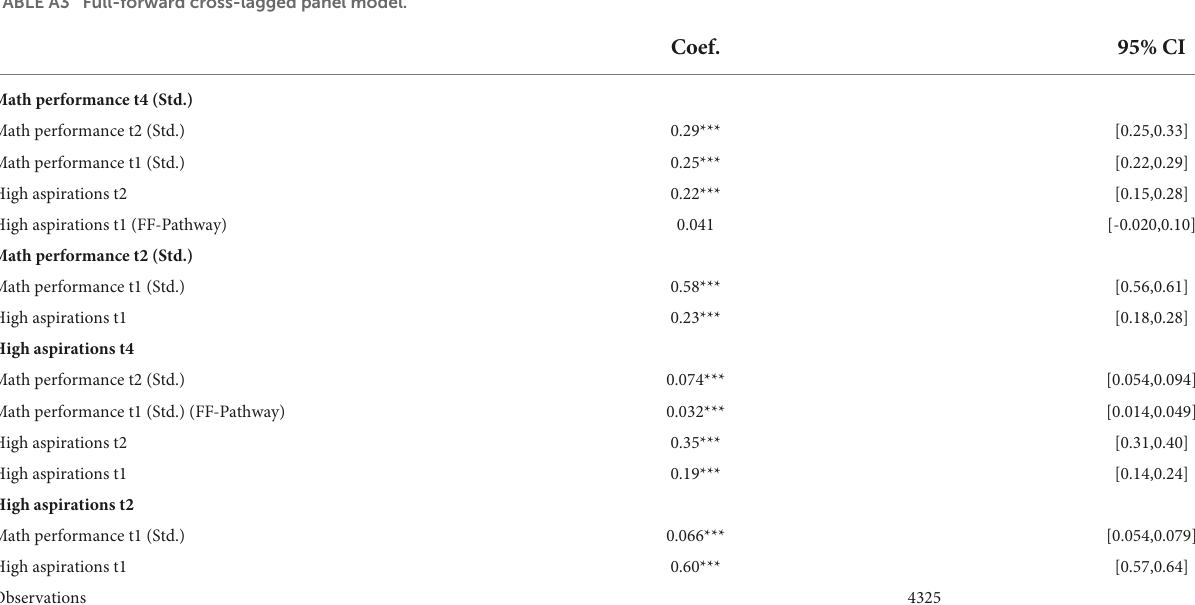
TABLE A3 Full-forward cross-lagged panel model.